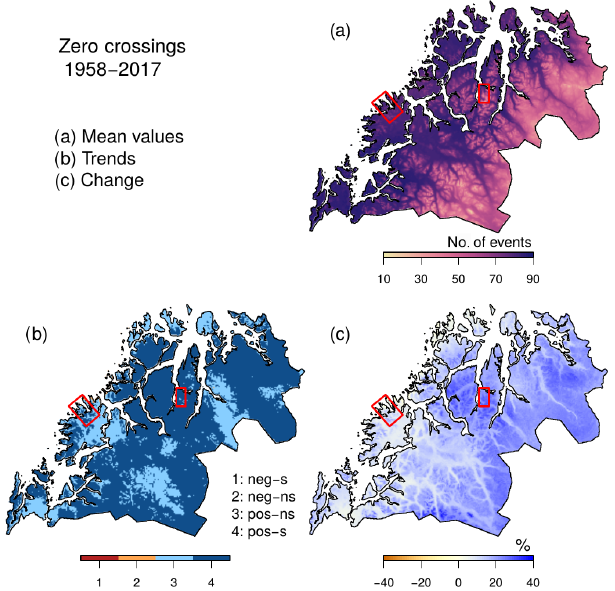
Figure 14. Frequency of rainfall events exceeding 10mm during winter (October–April) for the period 1958–2017, based on mini- mum and maximum daily temperature. Mean values (a) , trends (b) and changes are shown in the same way as in Fig.